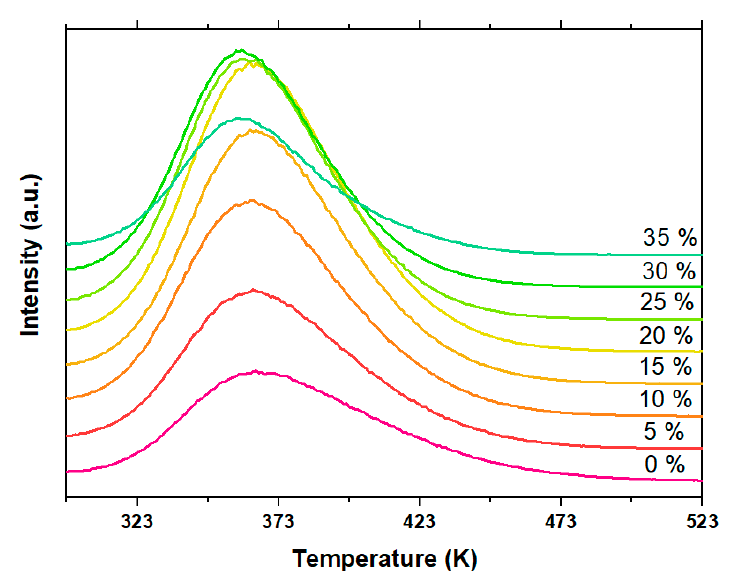
Figure 8. Variation in the peak shape of the TL glow curve for representative samples.